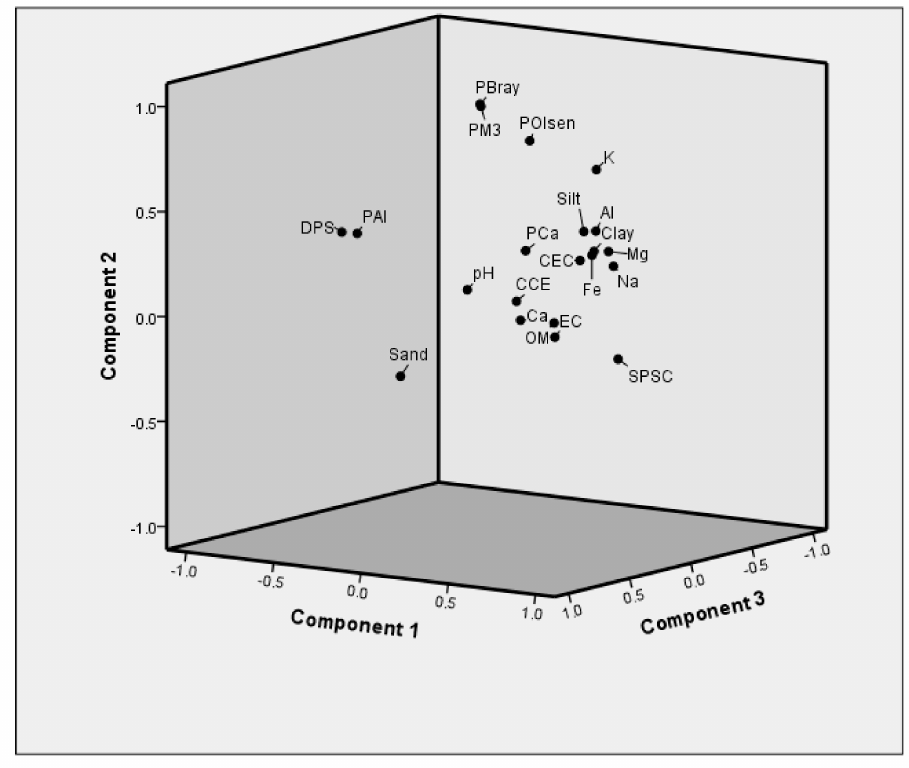
Figure 2. The principal component analysis loading plot of P extraction and soil properties in the studied